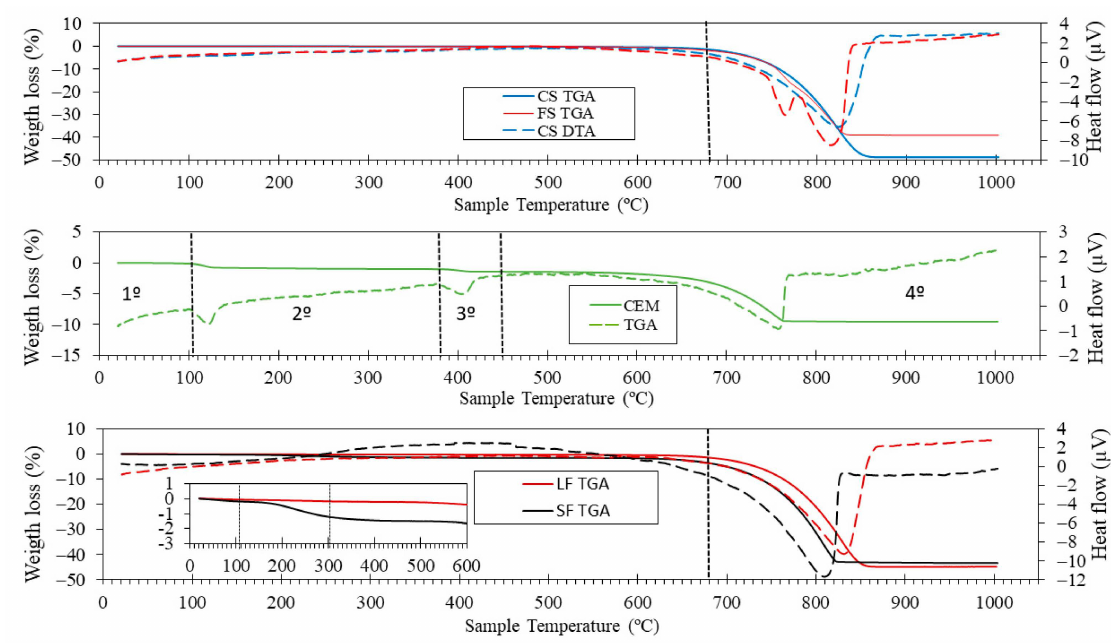
Figure 5. Thermogravimetric analysis (solid lines) and differential thermal analysis (dotted lines) for all the raw materials.